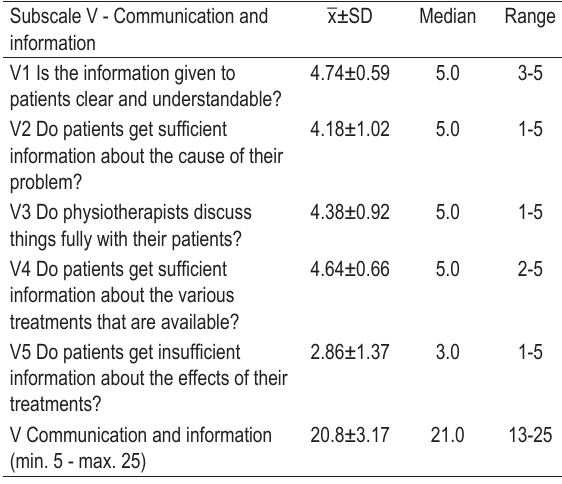
TABLE 6. Overview of mean scores – subscale V - Communication